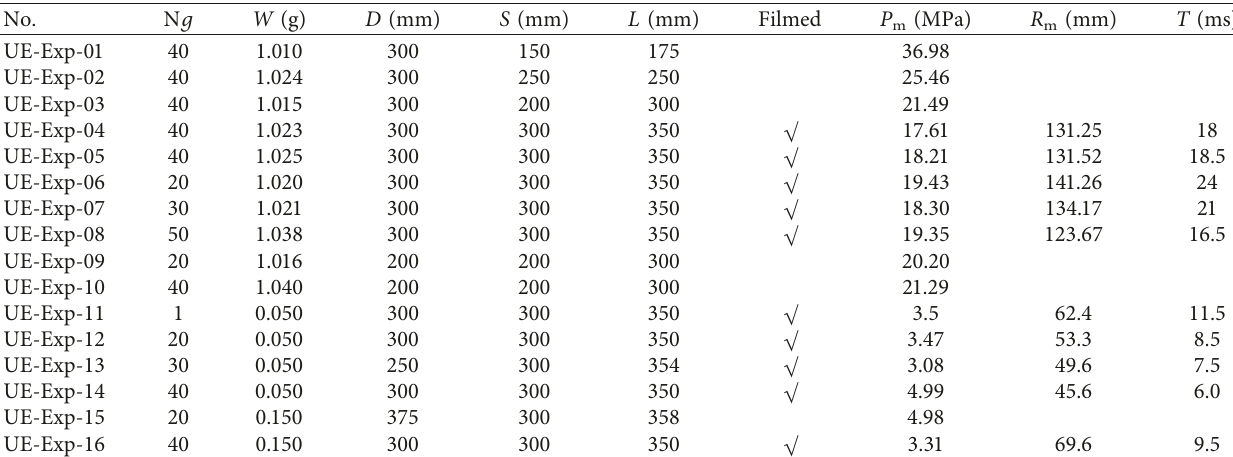
Figure 2: Test model. Table 1: Experiment